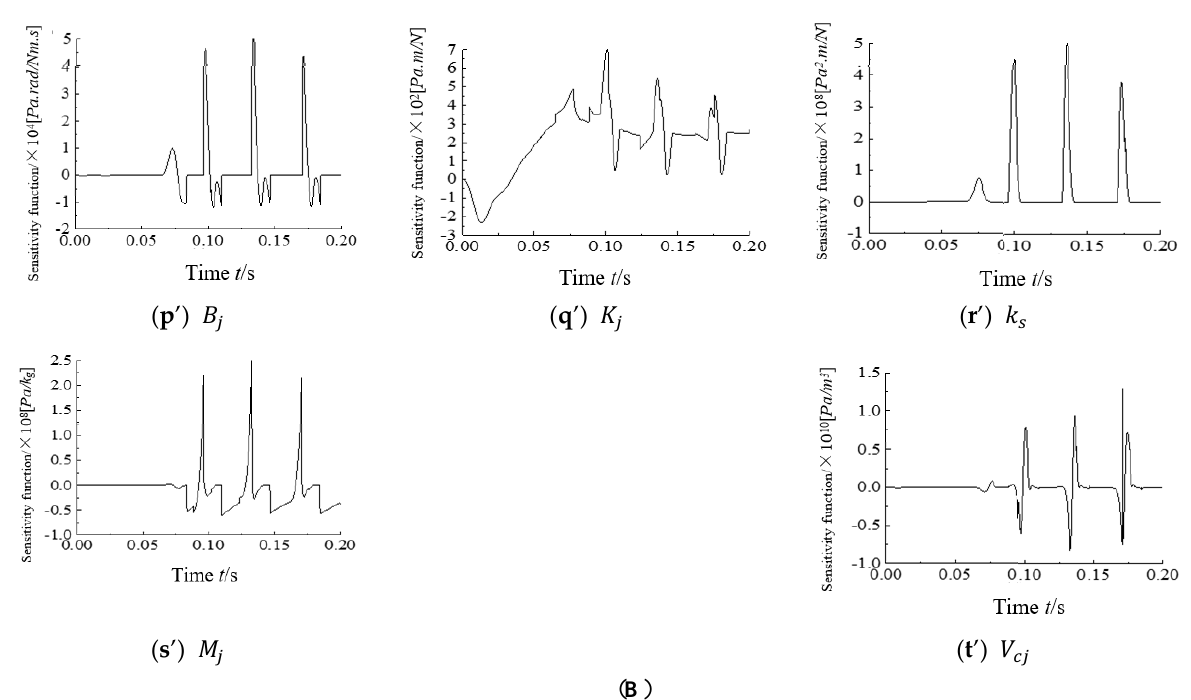
Figure 6. ( A ) The first-order trajectory sensitivity under 40 mA step signal (1). ( B ) The first-order trajectory sensitivity under 40mA step signal (2).